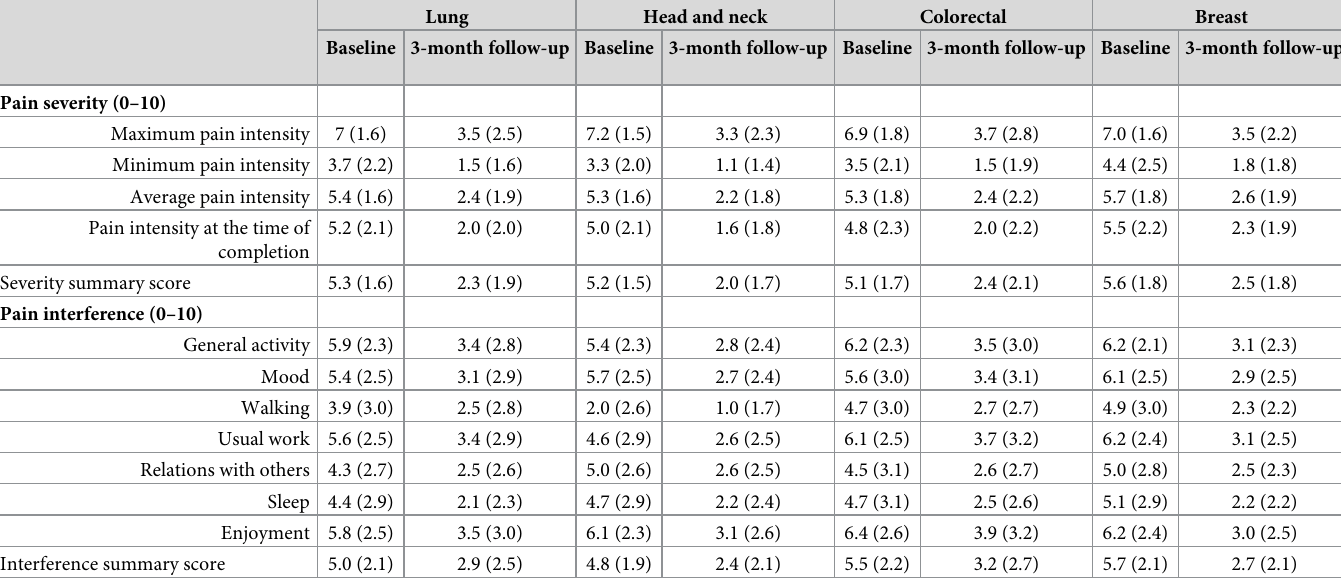
Table 2. Descriptive analysis showing scores on the Brief Pain Inventory by cancer type at baseline and 3 months, means and standard deviations. Lung Head and neck Colorectal